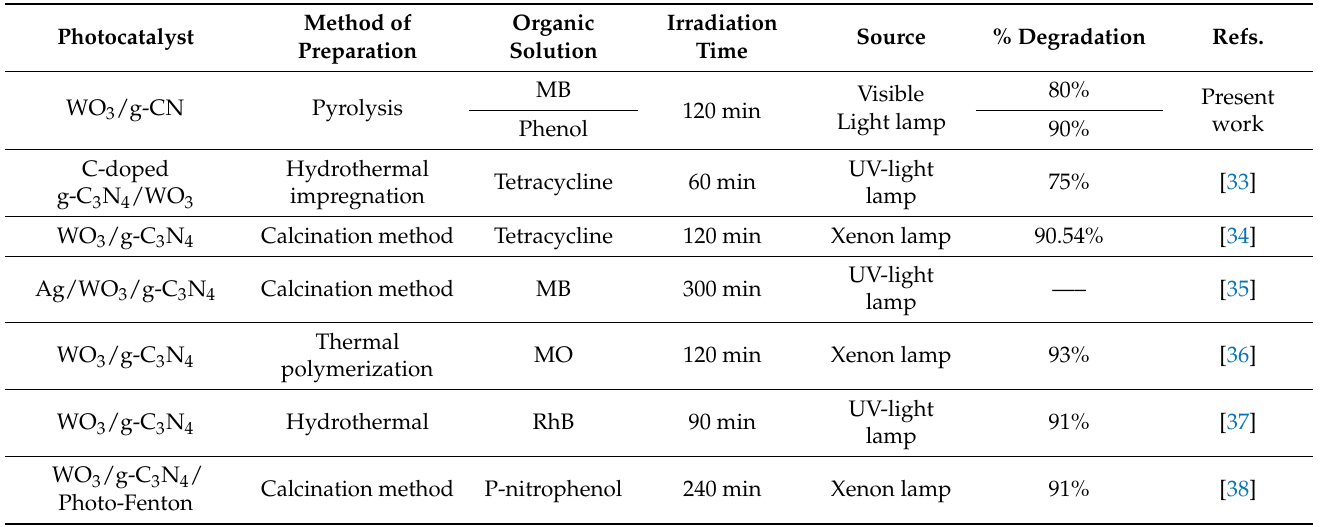
Table 3. Photocatalytic comparison between the prepared WO 3 /g-C 3 N 4 and various previous